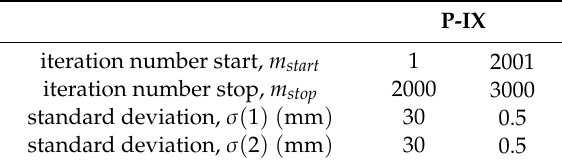
Table 8. Adjustment of local stochastic search algorithm by tightening search